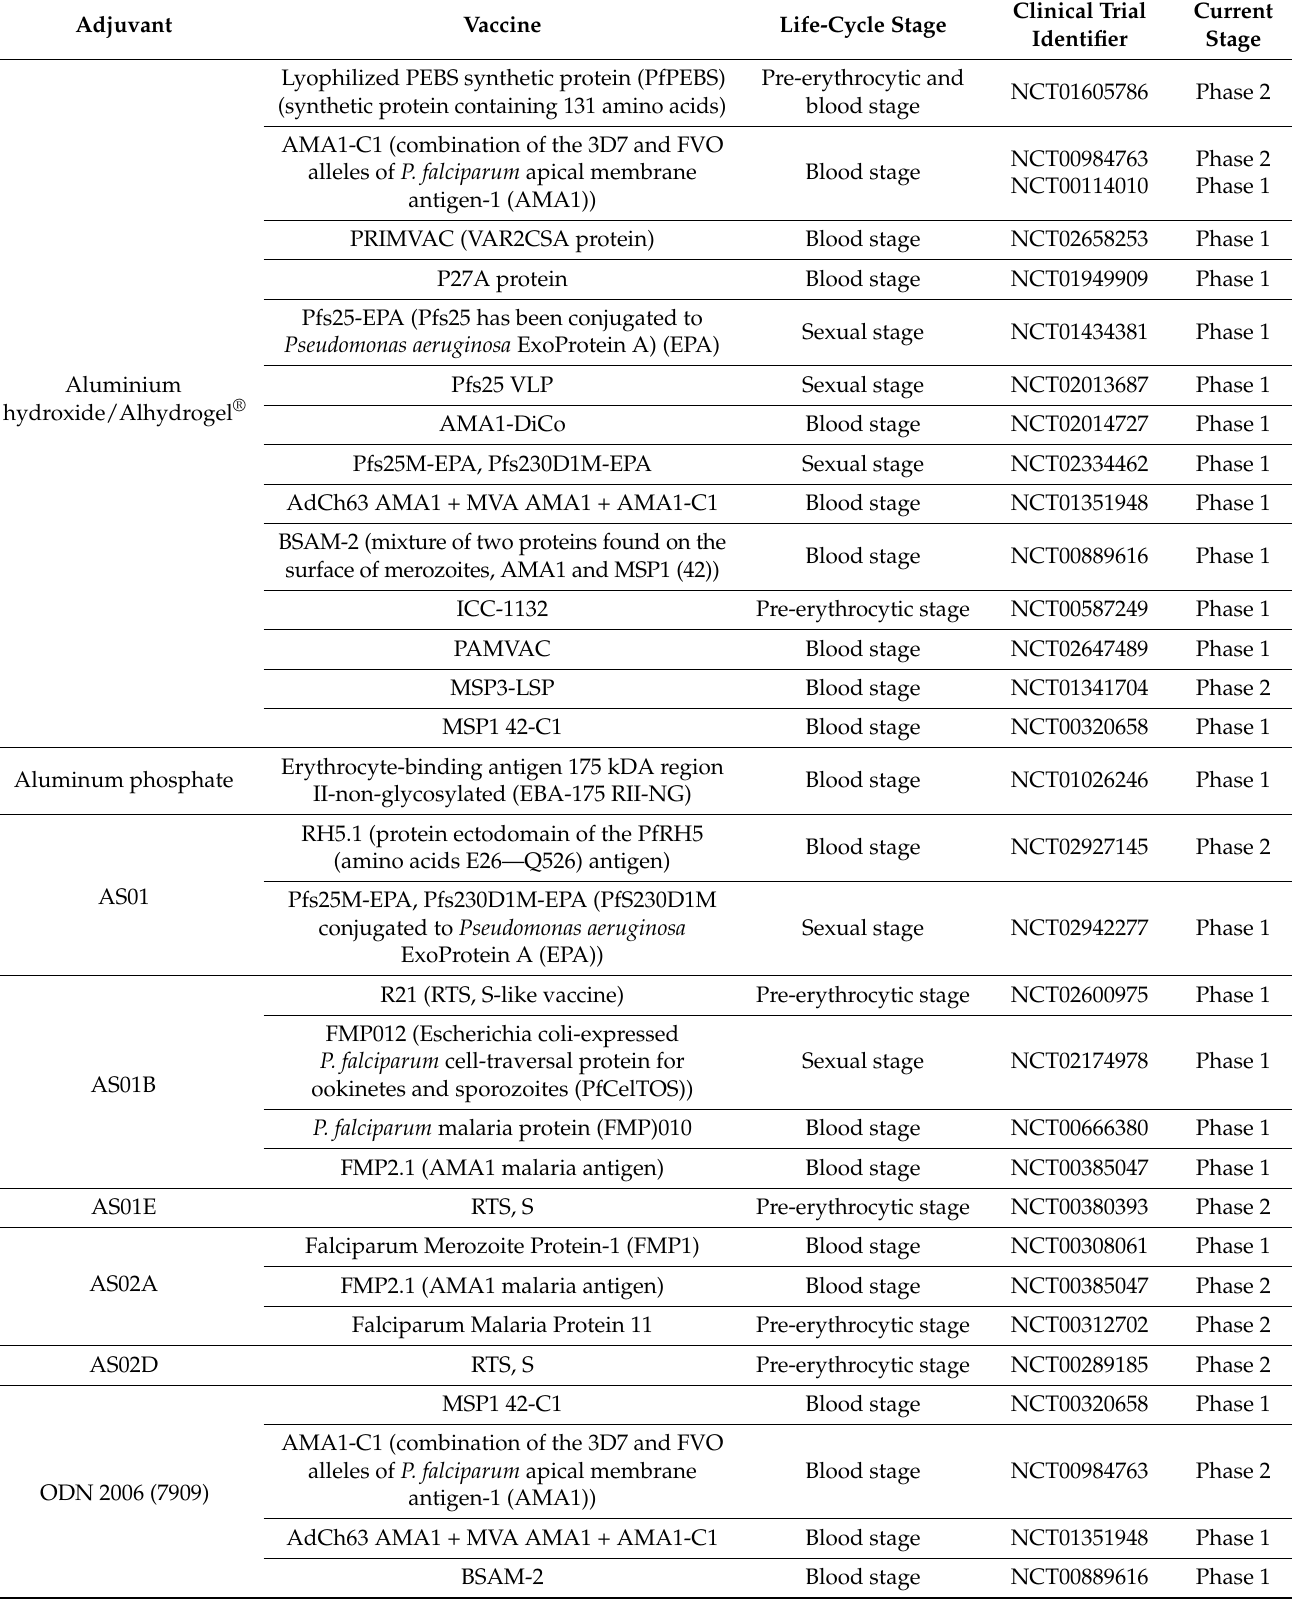
Table 2. Status of malarial vaccines with vaccine adjuvants #